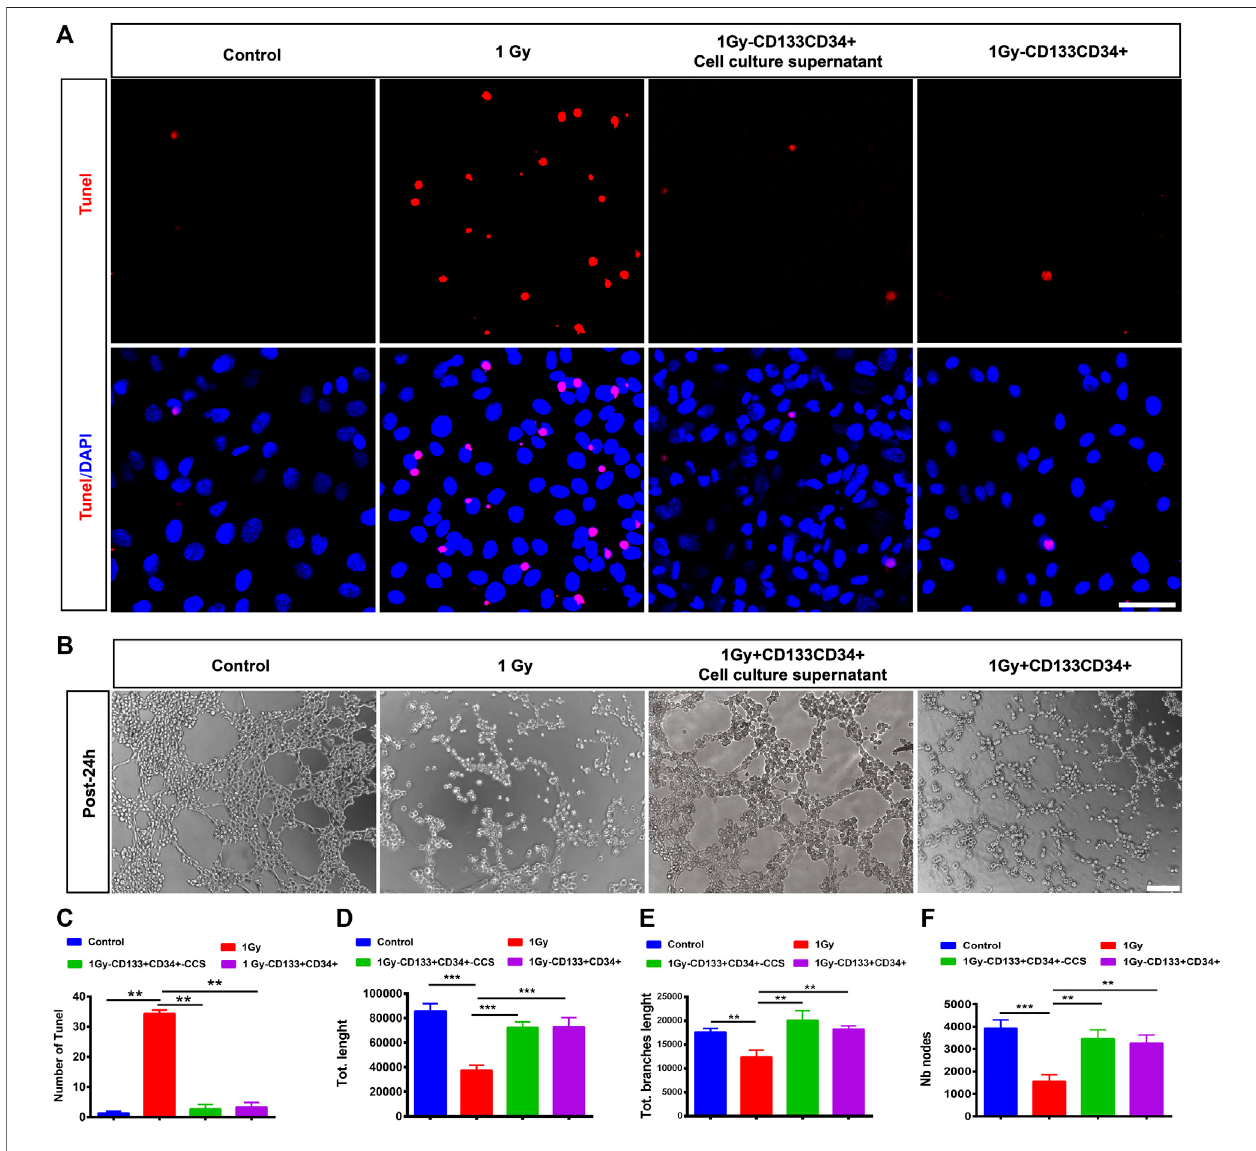
FIGURE 6 | Co-cultured CD133 + CD34 + cells or supernatant protected hRECs from radiation-induced injuries in vitro. (A) : Representative images showing the expressionofTunelonhRECswithcontrol(0 Gy),irradiated(1 Gy),coculturingwithCD133 + CD34 + cellandCD133 + CD34 + cellsupernatant24 hlater invitro .Scalebar: 50 μ m. (B) : The tube formation assay of hRECs with 1 Gy X-ray irradiation or irradiation combined coculturing with CD133 + CD34 + cells and CD133 + CD34 + cell supernatants24 hlater.Scalebar:100 μ m. (C) :ThestatisticsofthenumberofTunelpositivecells. (D – F) :Thestatisticsofthenumberofnodes,vessellength,and branches length. N = 3. Data are depicted as means ± SEM. (** p < 0.01, *** p < 0.001, ANOVA-test).